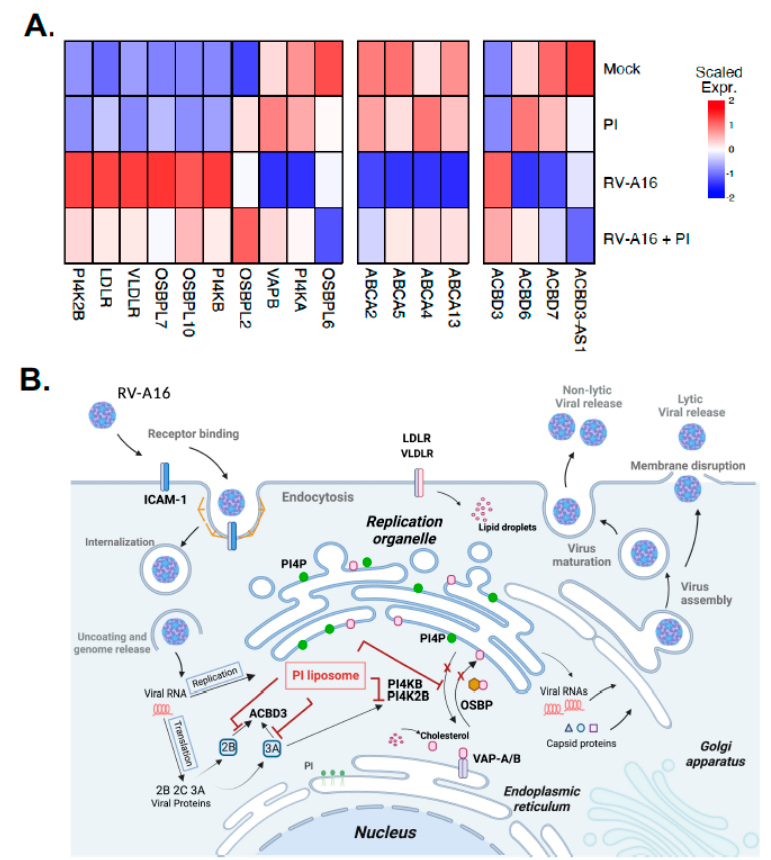
Figure 8. PI attenuated the RV–A16-mediated regulation of genes involved in replication organelle (RO) formation and function. ( A ) Heat map of scaled average normalized expression for each condition: (1) uninfected (mock), (2) treated with PI alone ( PI ), (3) virus-infected ( RV–A16 ), and (4) virus-infected and treated with PI ( RV16 + PI ) for RV–A16–regulated genes involved in RO formation and function. ( B ) Schematic of the RV-A16 replication cycle and the possible mechanisms of action of the PI liposome on RO formation and function.